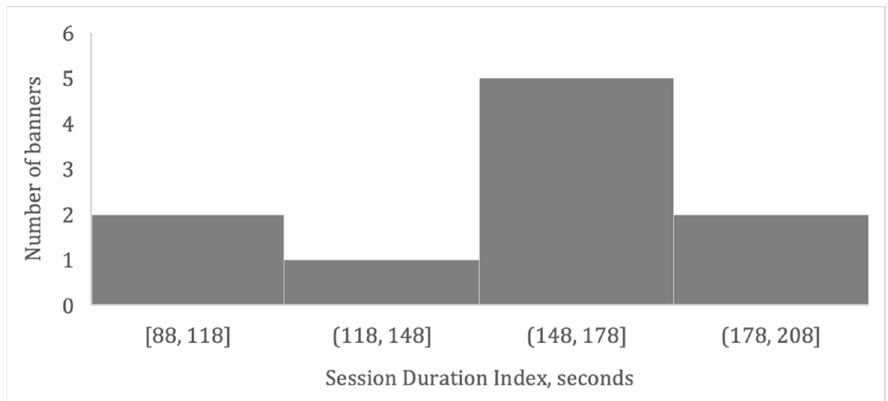
Figure 2. Population-level effects of ads. Distribution of the session duration index (SD index) across 10 banner ads.